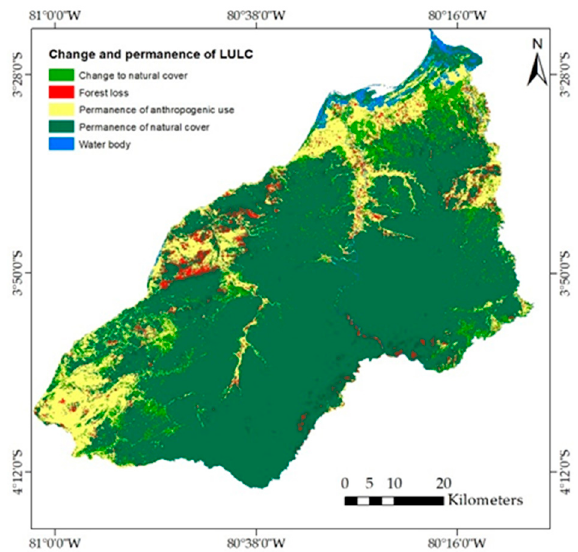
Figure 4. Maps of the change and permanence of LULC that occurred between 2017 and 2021 in the Tumbes region.